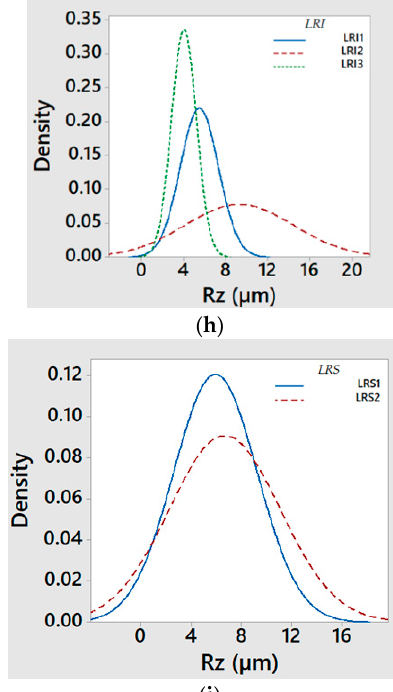
Figure 6. Graphic representation of the Ra values.